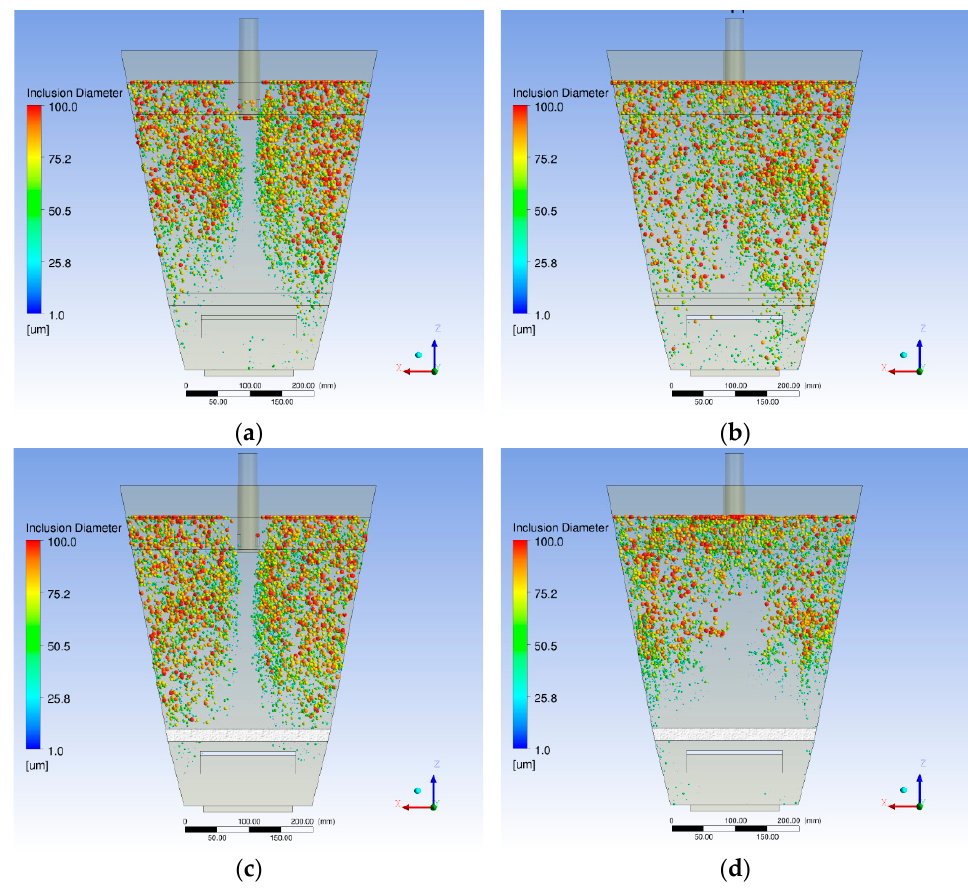
Figure 6. Distribution of inclusion particles predicted by the mathematical modeling using various experimental facilities. ( a ) Without the facility, ( b ) with the stopper, ( c ) with the stopper and porous baffle, ( d ) with the stopper, porous baffle, and magnetic field.